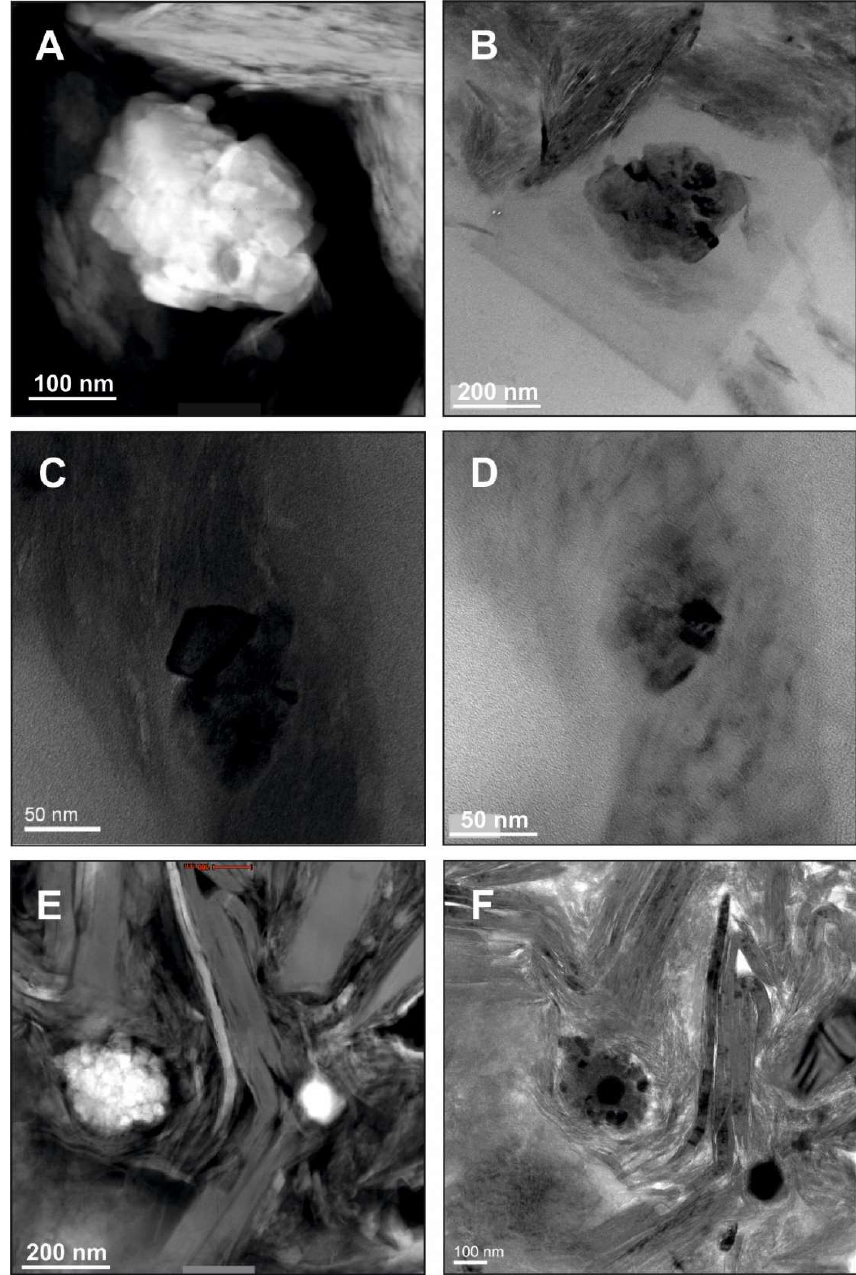
Figure 2. Titania (TiO 2 ) polymorphs (brookite in all selected samples) in selected black shales: Bakken Shale ( A , B ), Mediterranean sapropel S6 ( C , D ), and Schöneck Formation ( E , F ). ( A , C , D ) are high-magnification scanning transmission electron microscopy (STEM) images (high-angle annular dark-field (HAADF) mode), whereas ( B , D , F ) are TEM Bright Field images. The Pleistocene Mediterranean Sapropel S6 from the Eastern Mediterranean Sea was recovered from a sediment depth of 4.12 m (water depth, 2788 m), has a total organic carbon (TOC) content of 4‒6%, and is composed of marine organic matter (OM). The sample from the Oligocene Schöneck Fm. (Upper Austrian Molasse basin) originates from a well core from a depth of 1384 m, has a TOC content of 3.6%, and an immature lacustrine OM (hydrogen index, HI: 550 mg HC/g TOC). The Bakken Shale sample is of Upper Devonian to Lower Mississippian age, was drilled in the Williston Basin (North Dakota, U.S.A.), and comes from a depth of 2332 m. The TOC content is 8.3%, the marine OM has a HI of 416 mg HC/g TOC and an oxygen index (OI) of 27 mg CO 2 /g TOC.